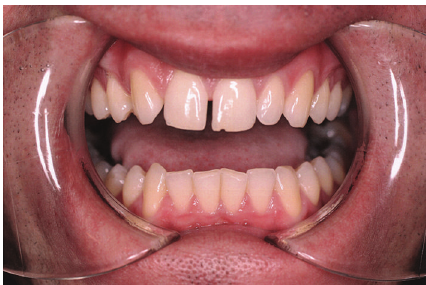
Figure 1: Physical examination reveals interincisal opening of 10mm.